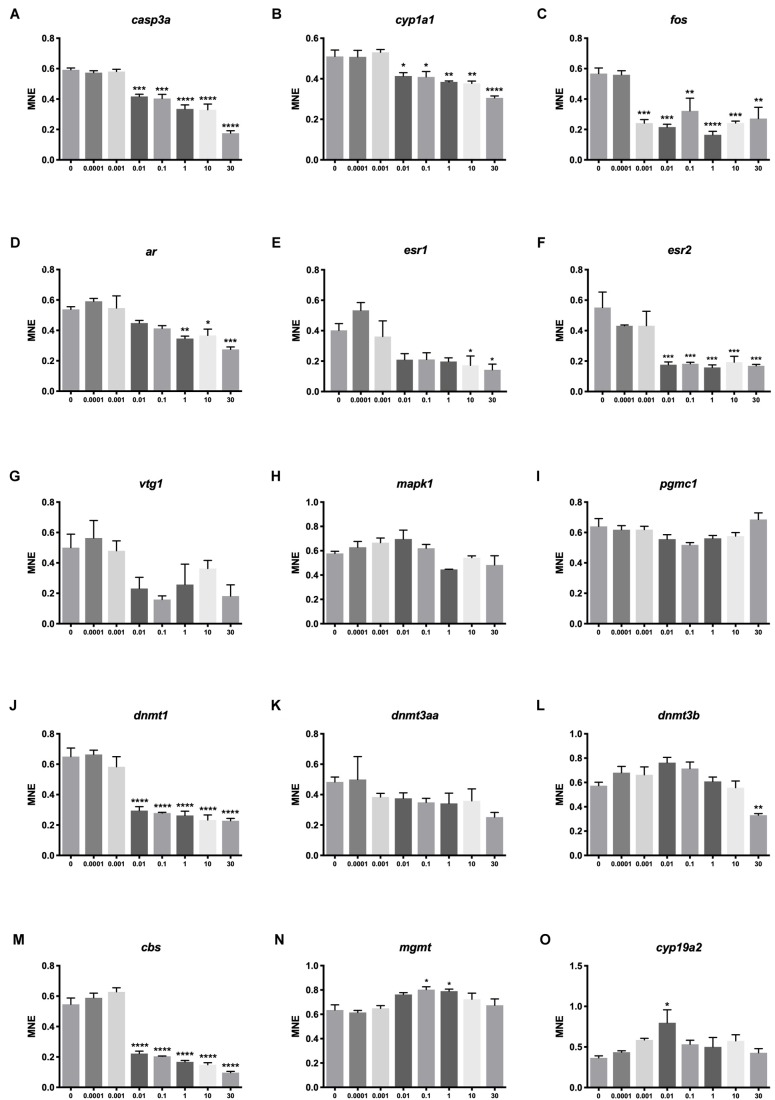
Transcriptional effects of BPA on zebrafish embryos. Concentration-response effects of BPA on selected genes encoding proteins linked to apoptosis (A,C,N), detoxification (B), reproduction (D–G,O), proliferation and differentiation (H), steroidogenesis (I), DNA methylation (J–L) and cysteine synthase activity (M). Asterisk indicates statistical differences in mean values between DMSO controls and exposed embryos with ANOVA (one-way ANOVA, Dunnett’s post hoc test, ∗p < 0.05, ∗∗p < 0.01, ∗∗∗p < 0.001, ∗∗∗∗p < 0.0001). Data are the mean ± SEM, n = 3, where each replicate is the average of 40 larvae. E3 control not shown.